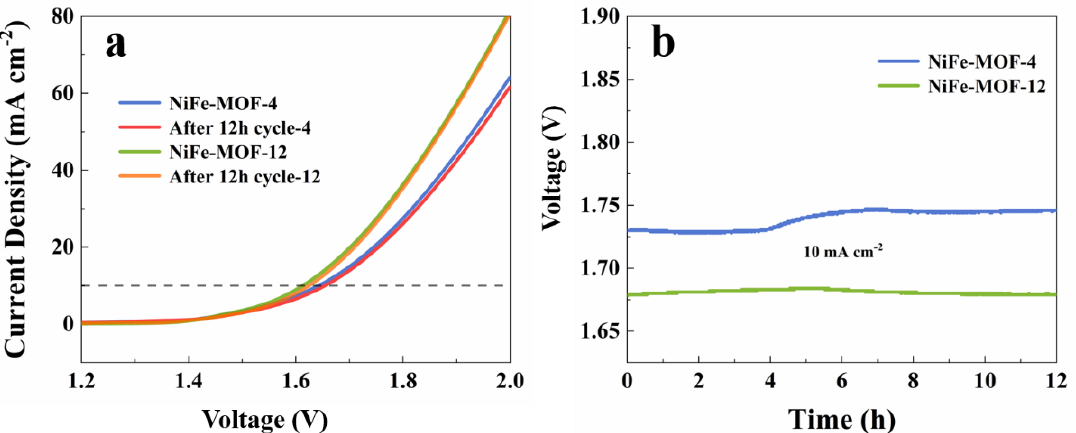
Figure 6. Electrochemical properties of overall water decomposition: ( a ) LSV curves of initial and after 12 h cycles of NiFe-MOF-4 and NiFe-MOF-12; ( b ) chronopotentiometry curves for NiFe-MOF-4 and NiFe-MOF-12 at a current density of 10 mA cm −2 .